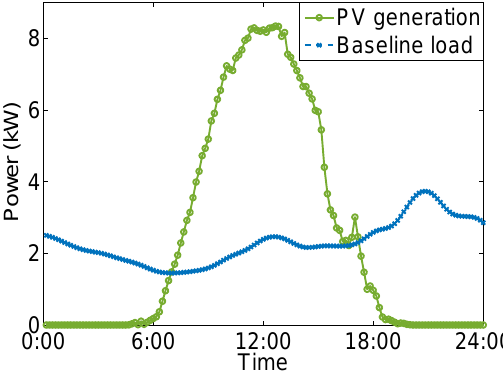
Figure 4. Power curves of PV generation and baseline